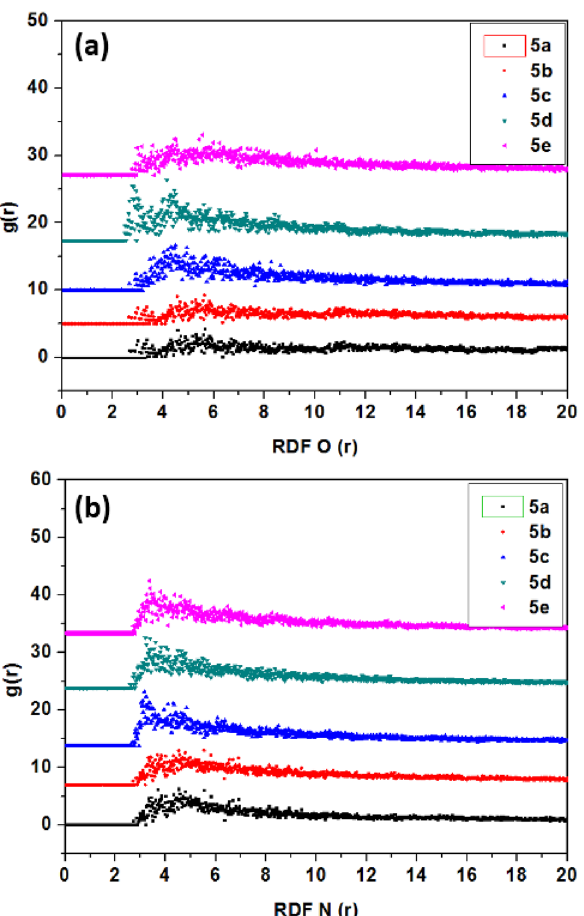
Figure 13. RDF O ( a ) and RDF N ( b ) of the pyrazolylnucleosides 5a – e on the Cu(111) surface in